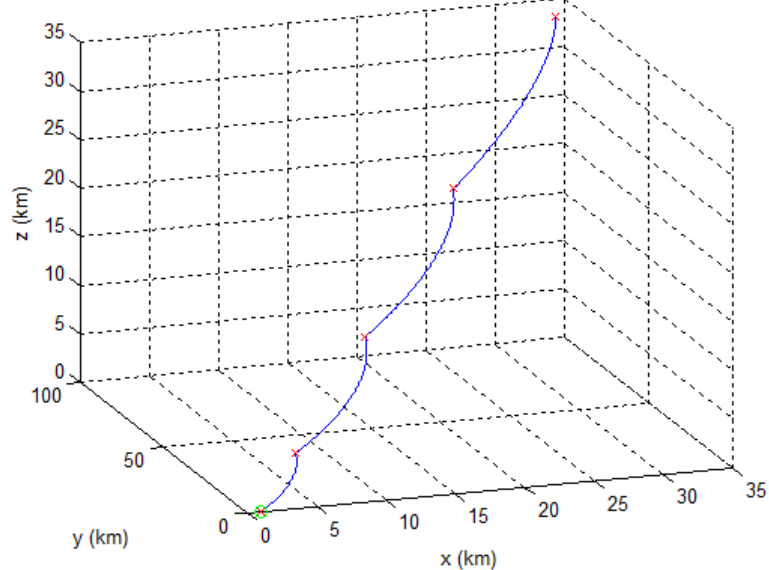
Figure 8. Baseline trajectory in the orbital frame ( ε = 2 initial inertial relative velocity.